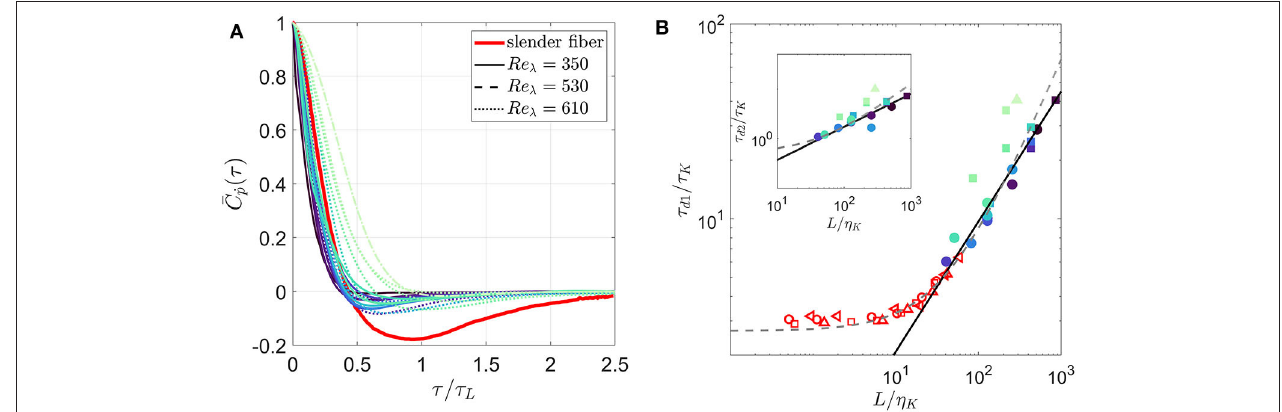
FIGURE 2 | (A) Lagrangian autocorrelation ¯ C ˙ p ( τ ) of tumbling rate, (B) the zero-crossing time τ d 1 and the integral time scale τ d 2 (see inset) for inertial fibers. Numerical result from Shin and Koch (2005) for a slender fiber with L = 41.7 η K , Re λ = 39.9 is included in (A) and slender fibers at multiple lengths and Re λ = 16.5 ( (cid:3) ), 30.7 ( # ), 39.9 ( △ ), and 53.3 ( ▽ ) are included in (B) for comparison. The dashed lines in (B) represent the linear fit ( τ d /τ K = 2.66 + 0.063 L /η K ) suggested in Shin and Koch (2005). This fit is multiplied by the mean ratio of the zero crossing time and the integral time from our data in the inset. Data include particles from very little inertia ( ) to those with St ˙ p > 0.7 (